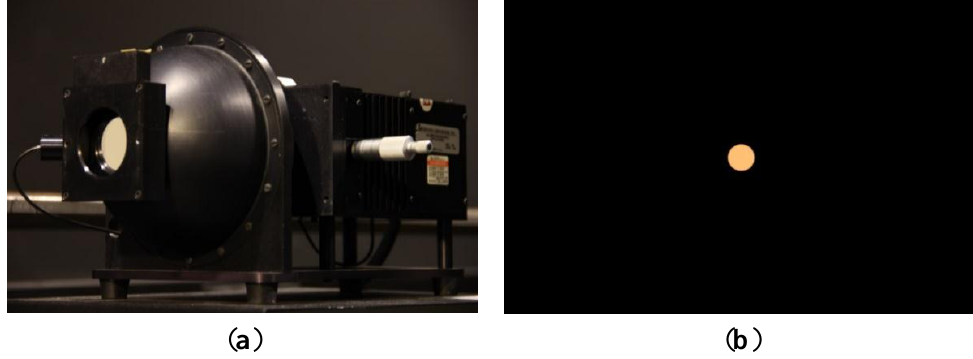
Figure 3. ( a ) Optronic Laboratories Inc. model 455-6-1 reference luminance source used for calibration. ( b ) The image covering the opening of the luminance